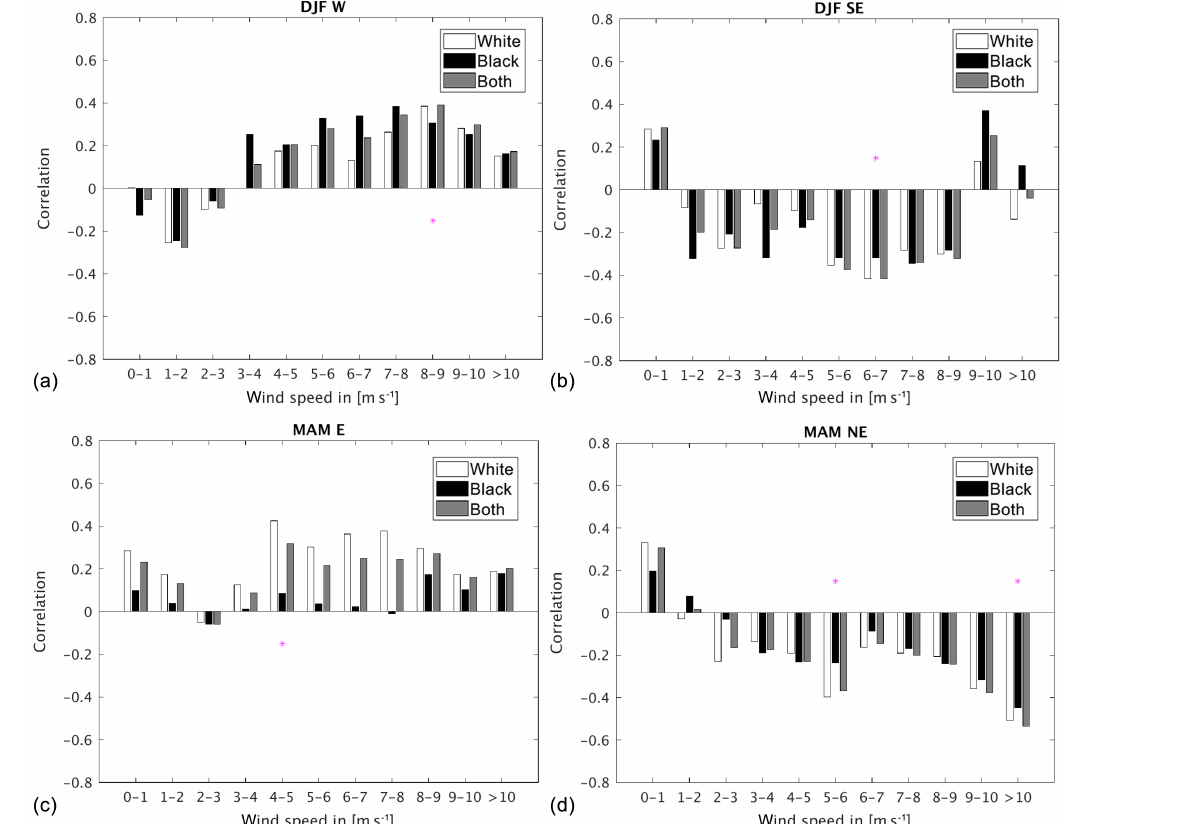
Figure 6. Correlation coefficients between the number of days per wind direction in a specified range of wind speeds and the dune thickness of the white layer (white), black layer (black), and both together (grey). The correlations are shown for winter (DJF; a and b ) and spring (MAM; c and d ) for the W (a) , SE (b) , E (c) , and NE (d) wind directions. The correlations marked with ∗ are significant at the 95%